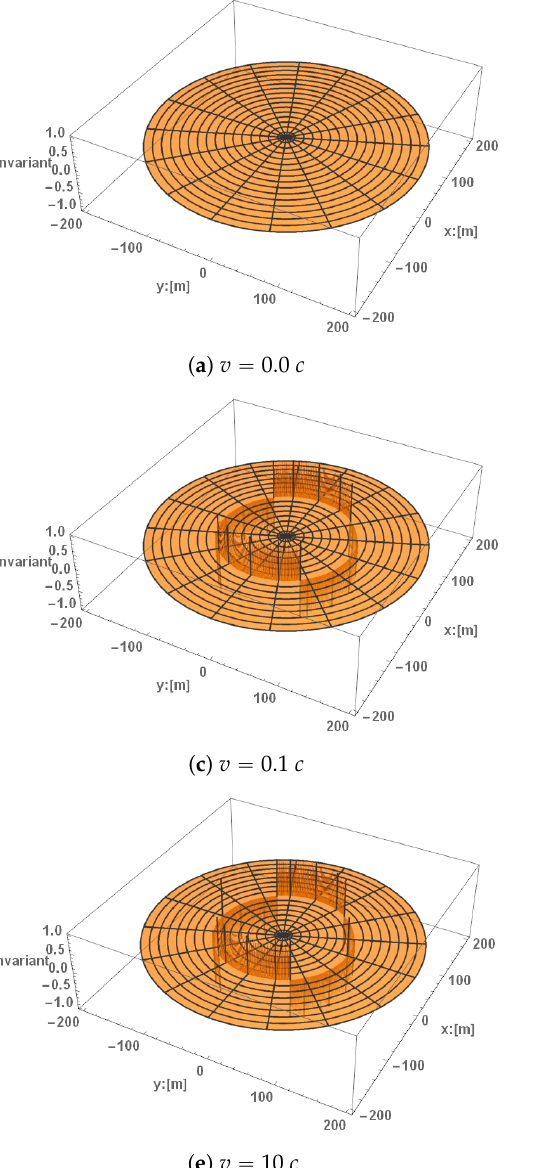
Figure A8. The velocity Evolution of the r 2 invariant for the Natário warp drive at a constant velocity. The other parameters are set to σ = 50,000 1 and ρ = 100 m. Equation (11) is in natural units, so the speed of light was normalized out of the m equation. The factor of c was included in these captions to stress that the plots are of multiples of the speed of light. Their units are ms ´ 1